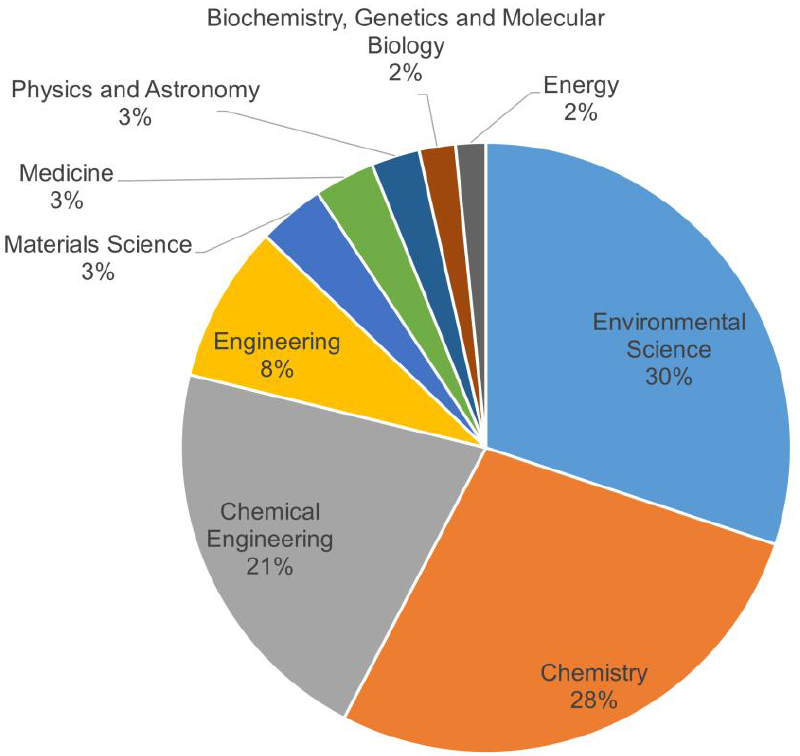
Figure 4. Distribution of the scientific publications according to subject area, based on the SLR article selection performed in the Scopus database. Considered period: 2002–2022. Source: the authors. In terms of dissemination, articles can be found in more than 60 different